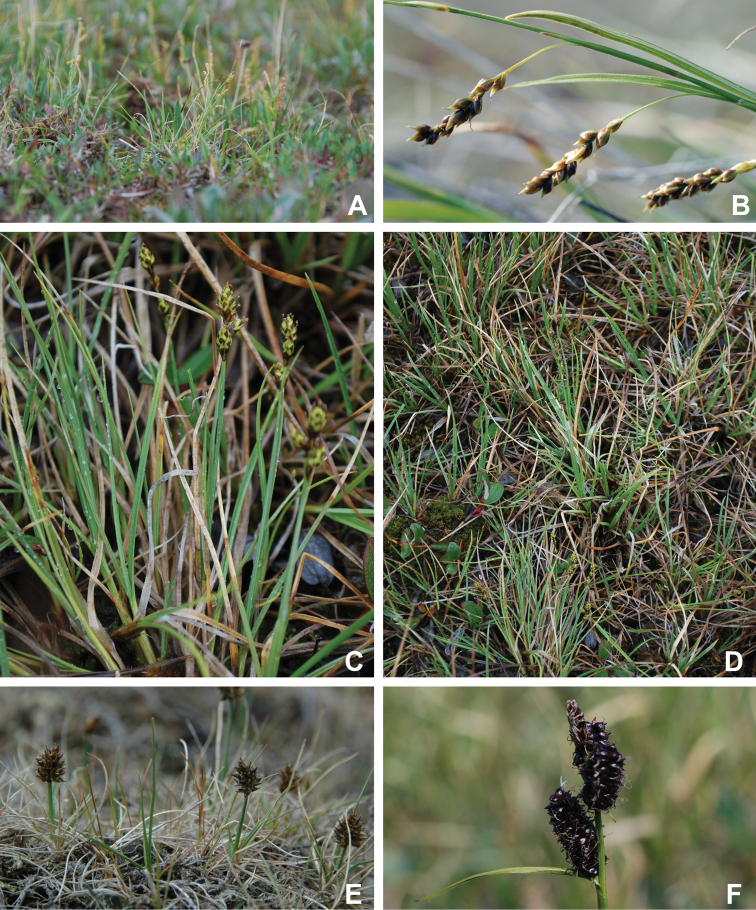
ACarex
krausei habit, Gillespie et al. 9977BCarex
krausei inflorescence, Gillespie et al. 8114CCarex
marina habit DCarex
marina habitat ECarex
maritima habit, Johansen Bay, NU, 18 July 2008 FCarex
membranacea inflorescence. Photos A, F by J.M. Saarela C, D by B.A. Bennett and B, E by R.D. Bull.